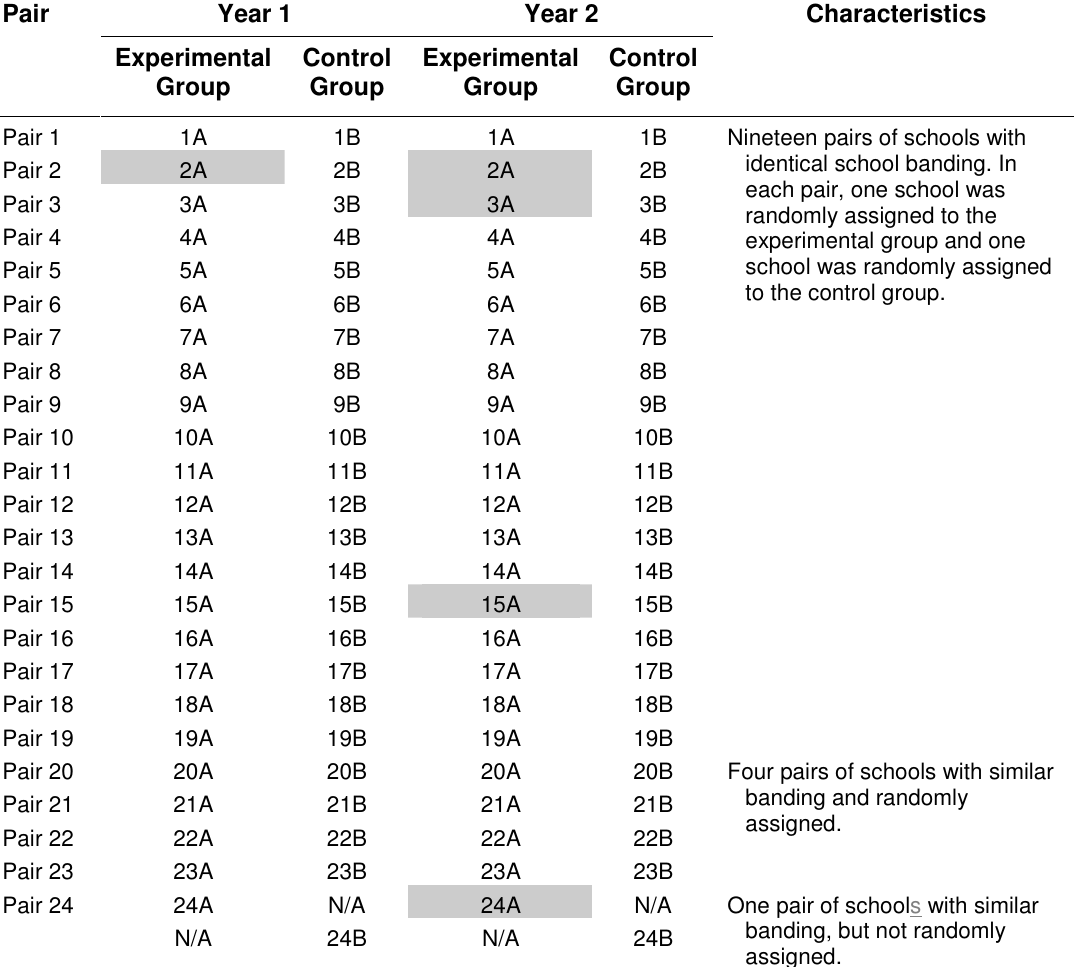
Characteristics